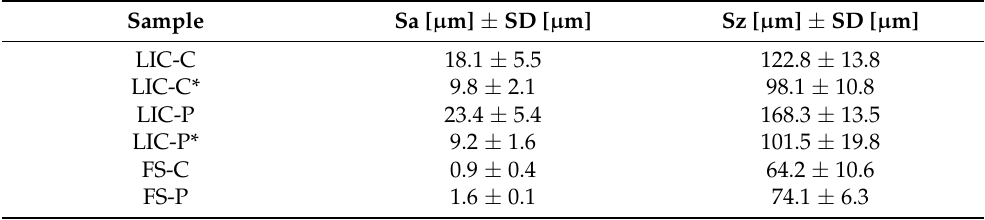
Figure 4. Surface topography of lubricated icephobic coatings (LICs) and flame-sprayed (FS) additive coatings measured using optical profilometry. Table 6. Average and standard deviation (SD) of the areal roughness parameters evaluated for lubricated icephobic coatings (LICs) and flame-sprayed (FS) additive coatings: average height (Sa) and maximum height (Sz).